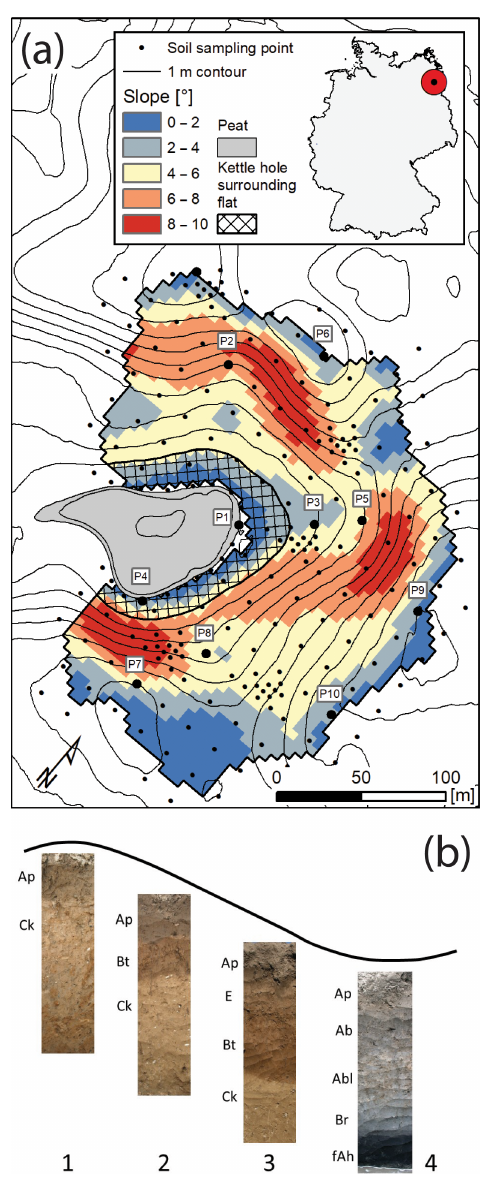
Figure 1. (a) Topography and nested soil sampling scheme in the young morainic study area in north-eastern Germany. P1 to P10 indicate the locations for high-resolution depth profile sampling (see Fig. 3). (b) Idealised catena for soil landscapes in hummocky ground moraines; 1: Calcaric Regosol (extremely eroded), 2: Nudi- argic Luvisol (strongly eroded), 3: Calcic Luvisol (non-eroded), 4: Gleyic-Colluvic Regosol